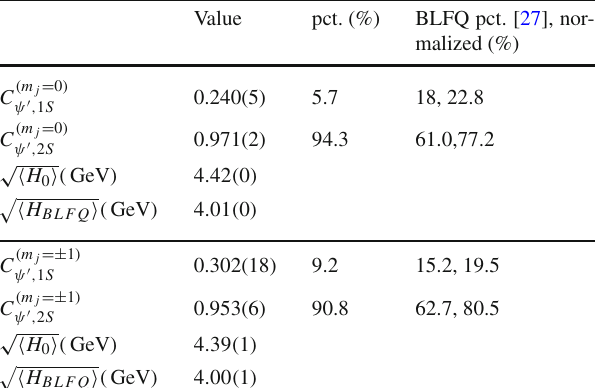
Table5 Thewavefunctionof ψ (cid:2) definedinEq.(51).Thevaluesofbasis coefficients are obtained by fitting the decay constant to the PDG value, at κ = ˆ κ, m f = ˆ m f . Uncertainties come from those of the parameters and the PDG decay constants. The percentage of each basis state is calculated by taking the square of the corresponding basis coefficient. The BLFQ values are extracted from the LFWF that is solved from the Hamiltonianformalism[27].Themesonmassisestimatedbyevaluating the expectation value of H according to Eq.